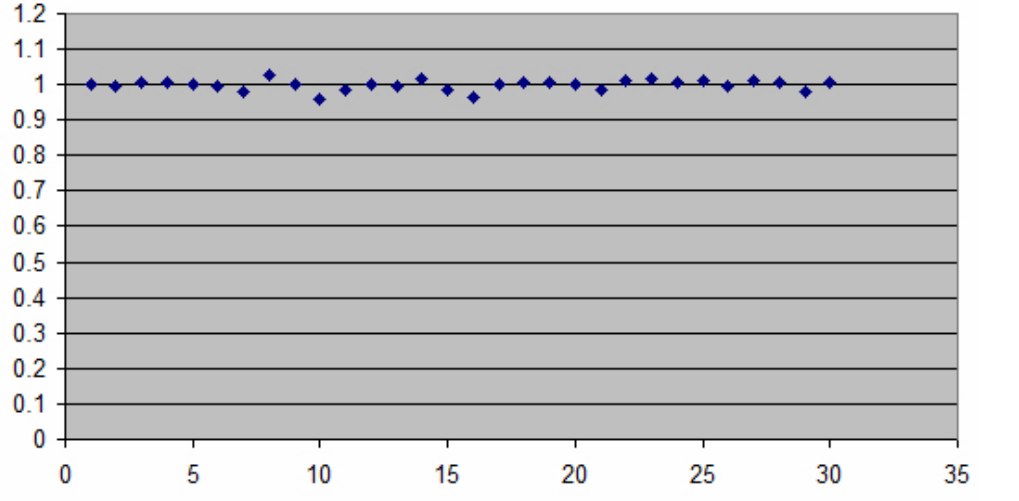
Figure 5. A scatter plot for all the 30 free fall trials.